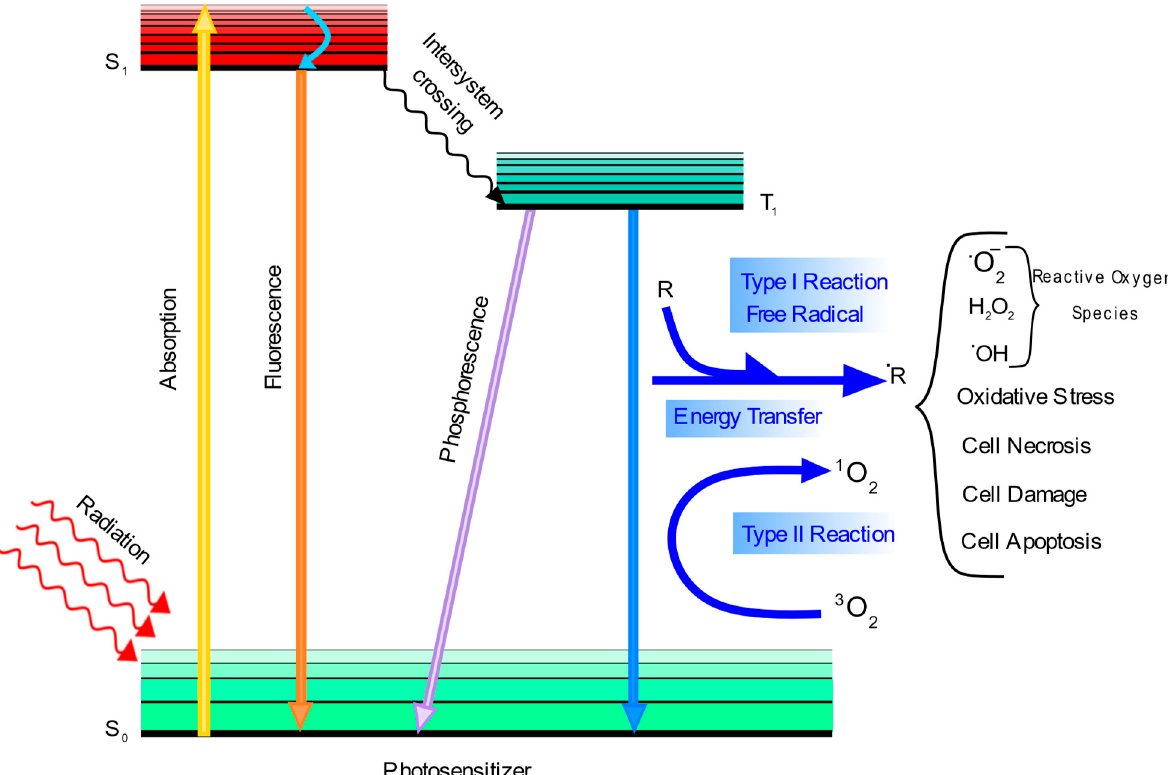
Figure 1. Mechanism of photodynamic therapy (figure created with Inkscape).